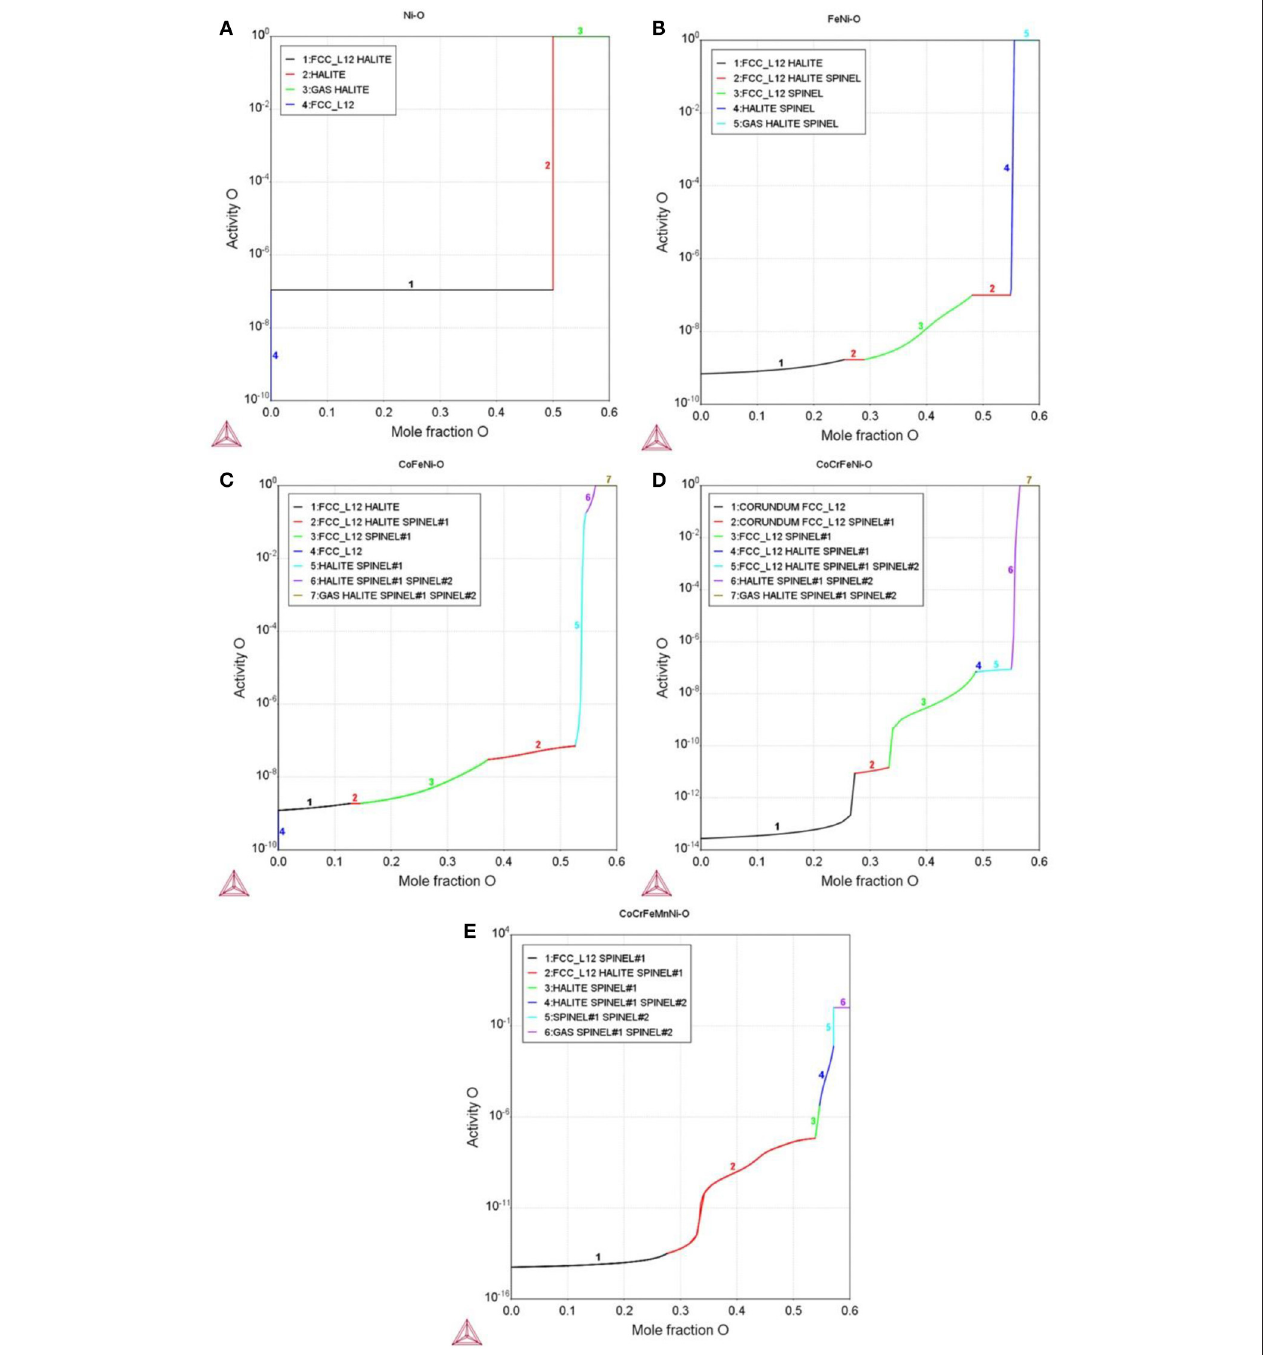
FIGURE 6 | Calculated oxygen activity corresponds to various phase equilibria at 800 ◦ C for the oxidation of different metal systems. The reference state is the gas phase at this temperature. (A) Ni-O; (B) FeNi-O; (C) CoFeNi-O; (D) CoCrFeNi-O; (E) CoCrFeMnNi-O.